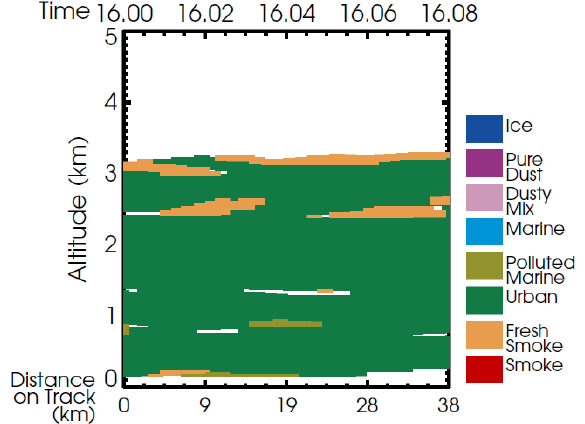
Figure 3. Curtain plot of aerosol typing of measurements from 16:00 to 16:05UTC on 17 July 2012. Aerosol typing was carried out according to the scheme described by (Burton et al.,